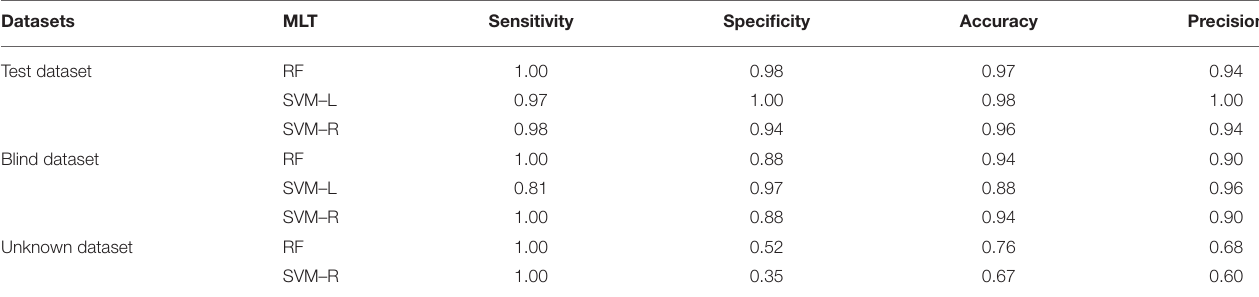
TABLE 2 | Comparative performance measurement among three different MLT methods using three different datasets with 10-fold cross-validation. Datasets MLT